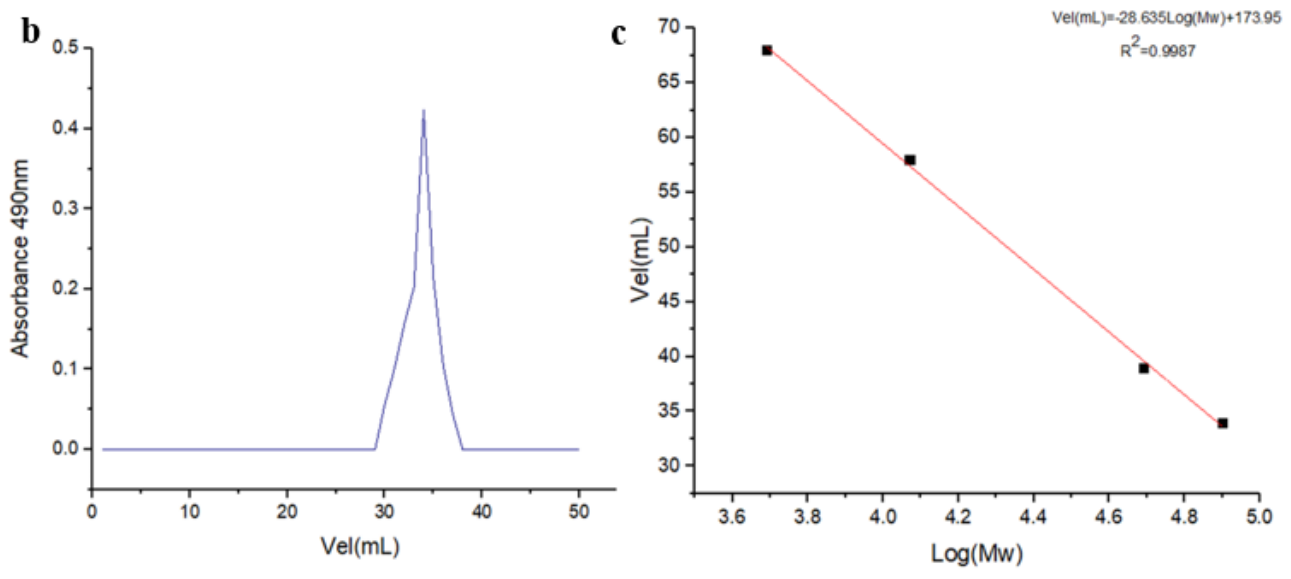
Figure 2. ( a ) The 1H-NMR spectra of Tween 80 initially and after 72 h of biodegradation. ( b ) The elution curve of EPS RT7 by Sephadex G-100 gel filtration. ( c ) The standard curve of relative molecular weight (Mw).